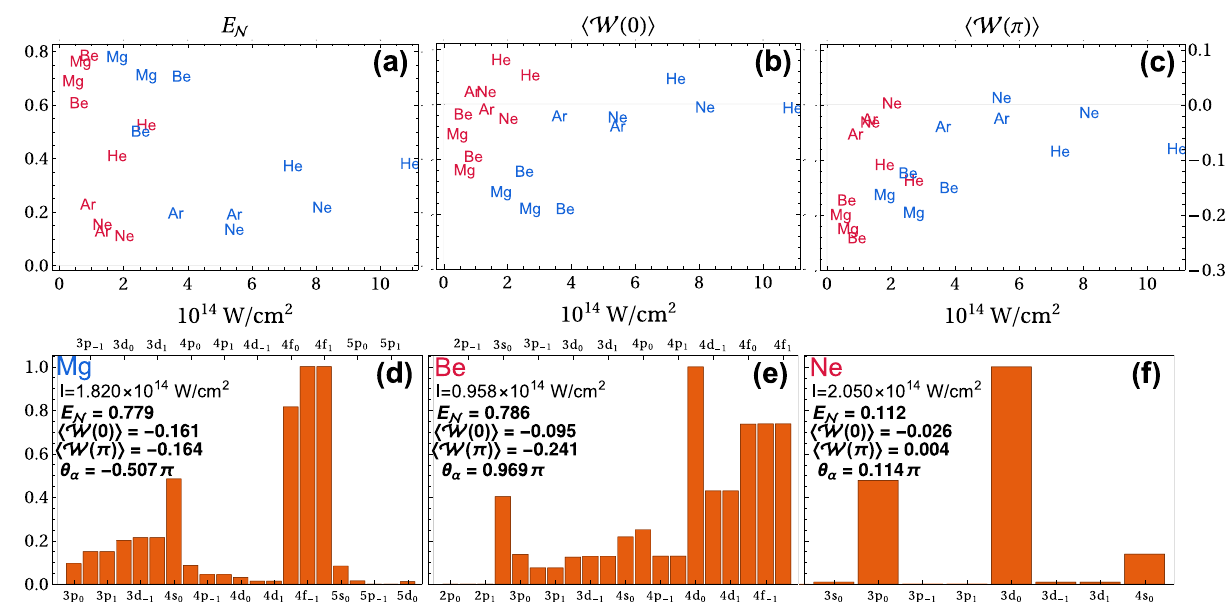
Fig. 2 | Extensive search over targets and parameters. a Quanti fi es the entan- glement using the logarithmic negativity ( E N of (10)). b and c Expectation value of the entanglement witnesses ( h W ð 0 Þi and h W ð π Þi , see (12)), respectively. Here, h W i : =Tr ½ W ρ (cid:2) . Blue text indicates λ =400nm and red λ =800nm. OAM d , e , f Estimated contribution of intermediate excited states for three extremal cases Mg, Be and Ne, respectively. The fi eld values are given on the panels. The